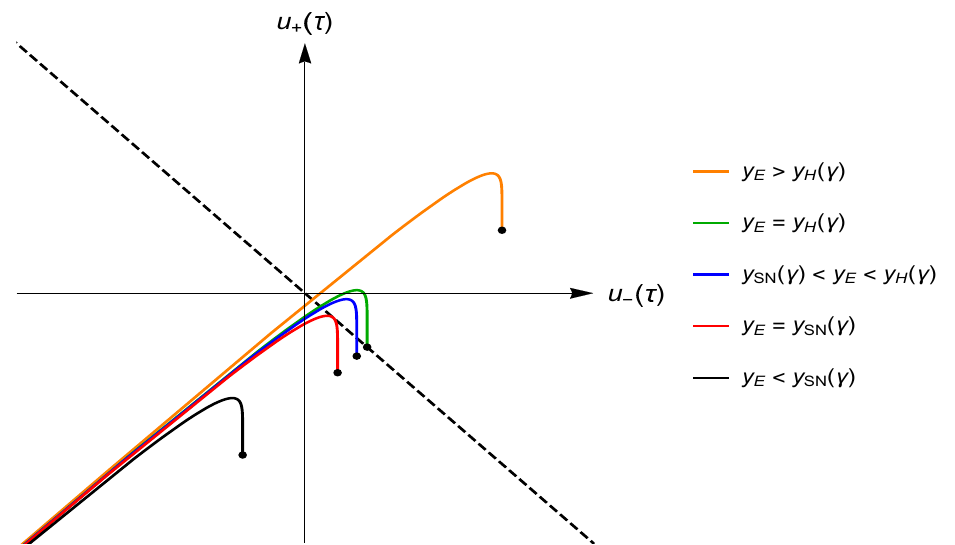
Fig. 6 The transition map U for different values of y E . Again, the terminal black points in this figure represent the point u ∗ = ( u ∗ , u ∗ ) for each case. − +